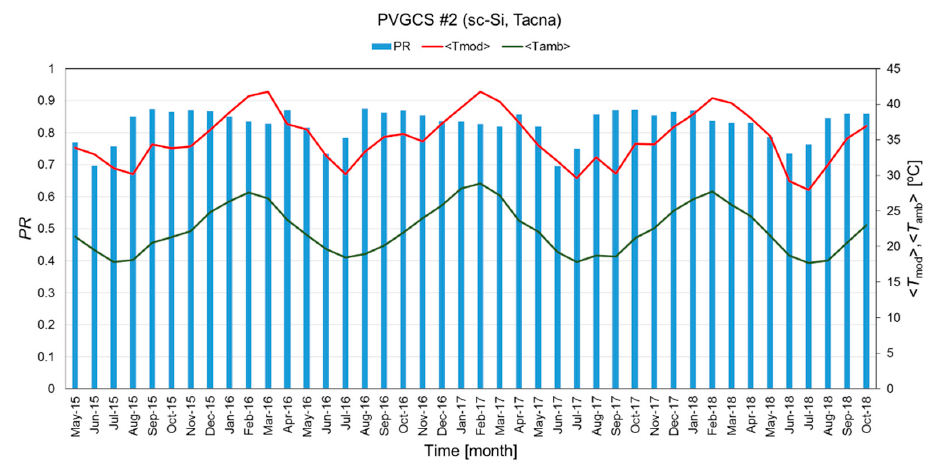
Figure 7. Values of PR , < T amb >, and < T mod > for PVGCS #2 over the period under scrutiny. N.B. only values of temperature recorded during daytime are considered in the calculations.